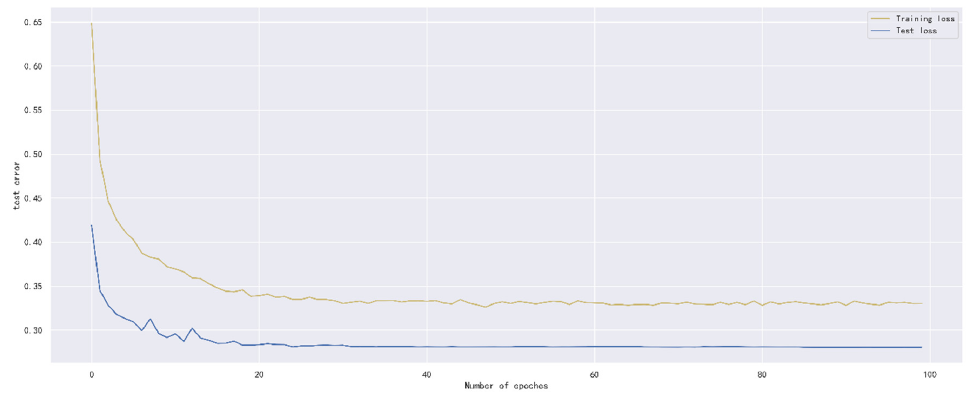
Figure 8. The relationship between Bi-GRU model and training rounds.